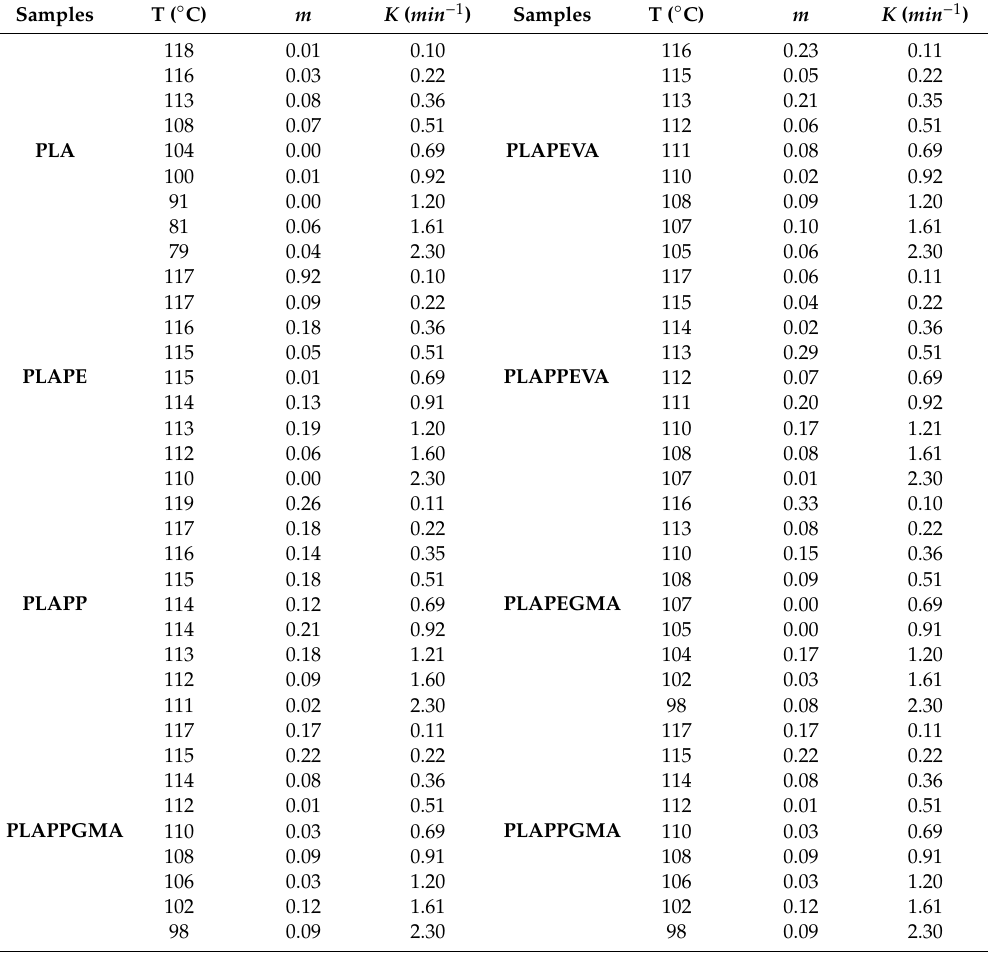
Table 4. Crystallization kinetic parameters at various cooling rates for various PLA / POE blends based on the Ozawa